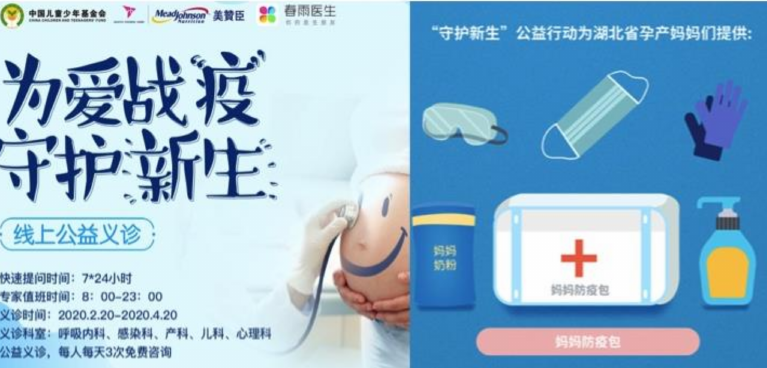
Figure 3. Screenshot of Mead Johnson’s campaign from the China Children and Teenager Fund’s website, with the caption “Conquer virus for love to protect new lives” (translated from Chinese). Image on the right shows items in donation packets, including milk for mothers.